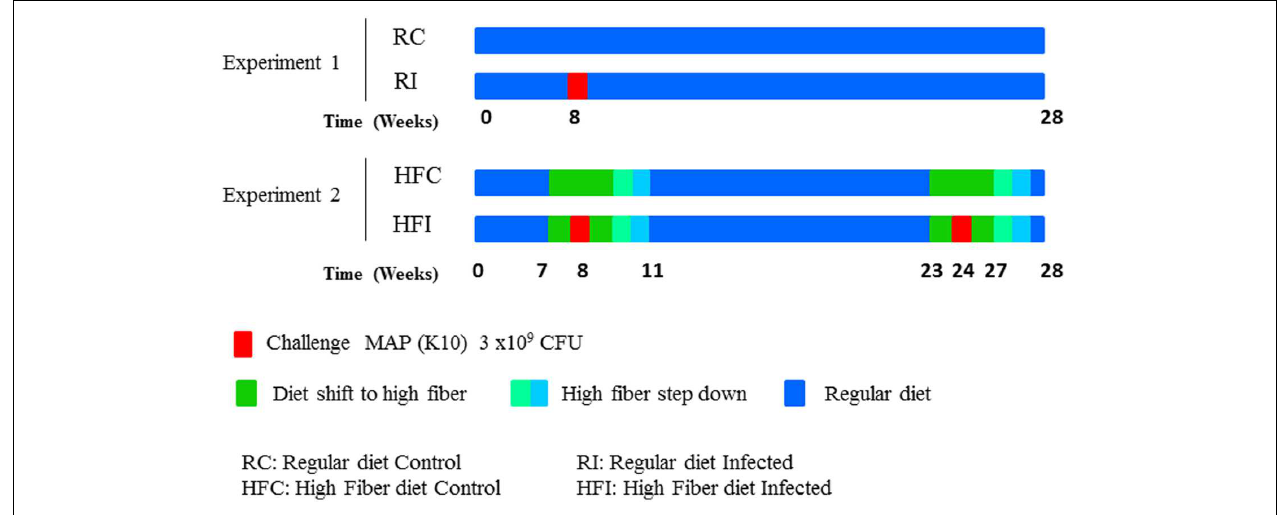
FIGURE 1 | Experimental design